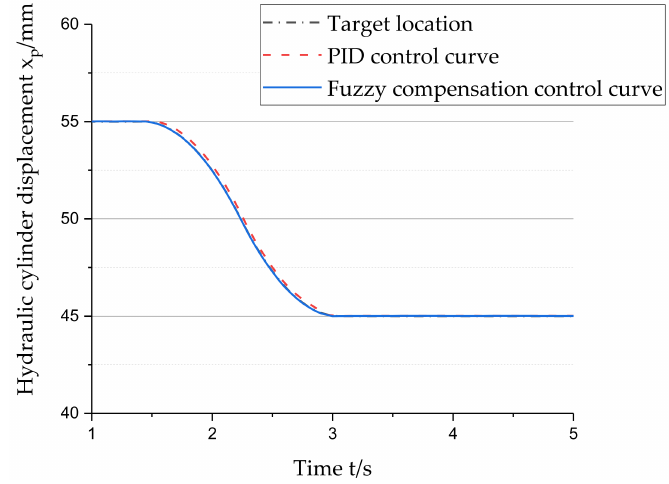
Figure 11. Response curve of the retracted position of the hydraulic cylinder.